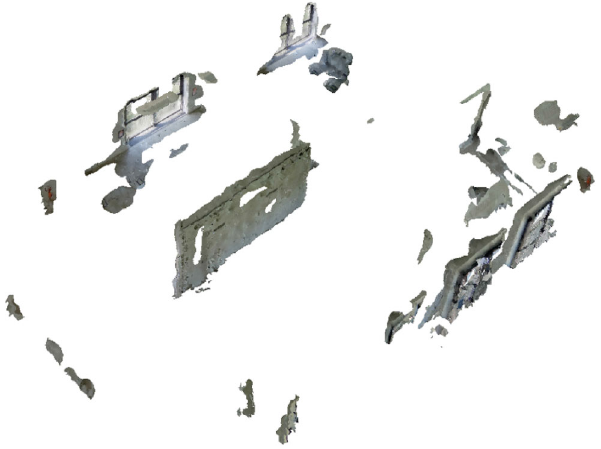
Fig. 13 Reconstruction from the point cloud only, showing the output of a dense multi-view pipeline ( PhotoScan ) applied to the D4 dataset. Mesh extraction and tiled model recovery have been also applied to enhance the illustration.